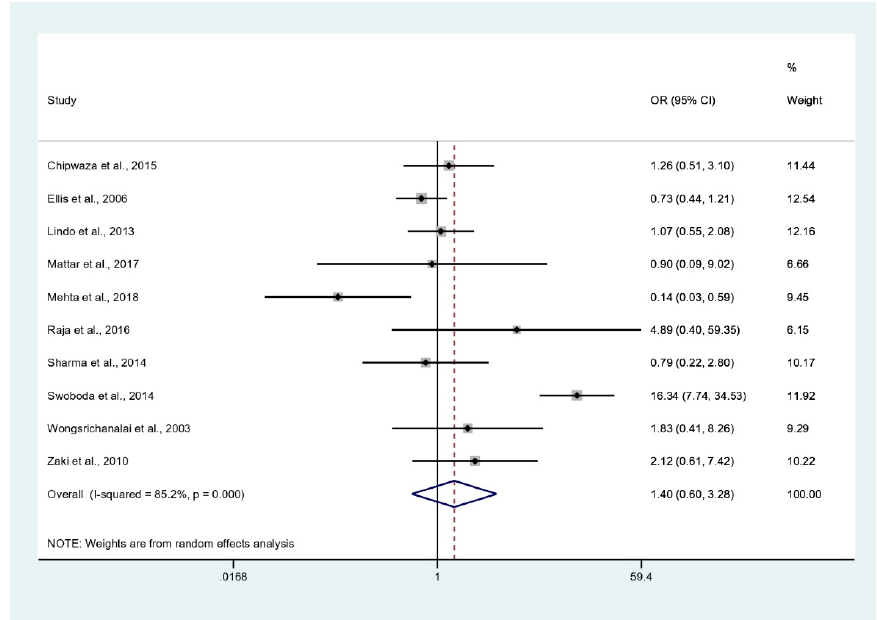
Figure 7. Odds of malaria and leptospirosis co-infections. % Weighted: the impact proportion of each study to the pooled effect; black dot symbol on black horizontal line: point estimate for each study; black horizontal line: CI, white diamond symbol: odds ratio; CI: confidence interval; ES: effect size (odds ratio).